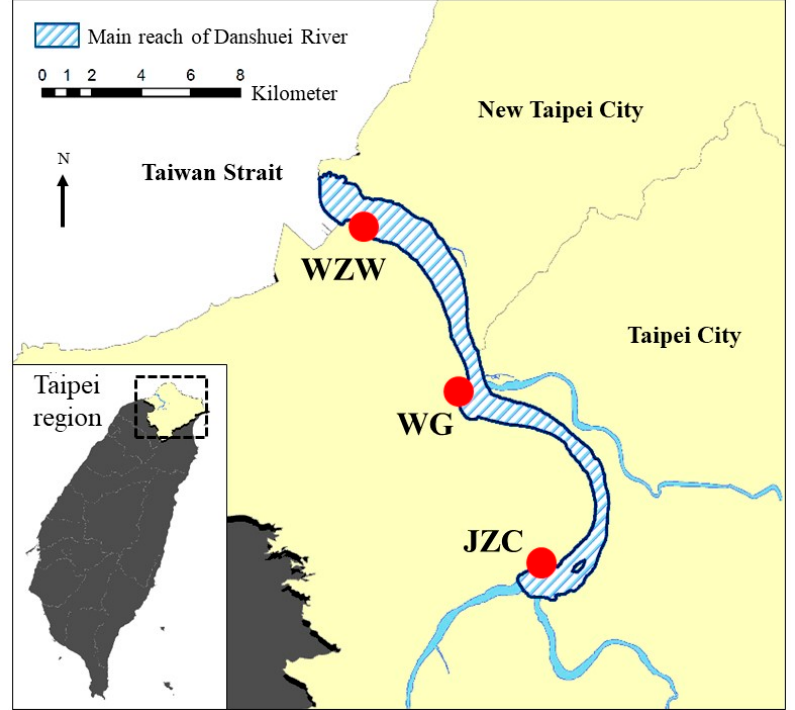
Figure 1. Map showing the three study sites, Waziwei (WZW), Wugu (WG) and Jiangzicui (JZC), along Danshuei Riverine Mangrove in Northern Taiwan.